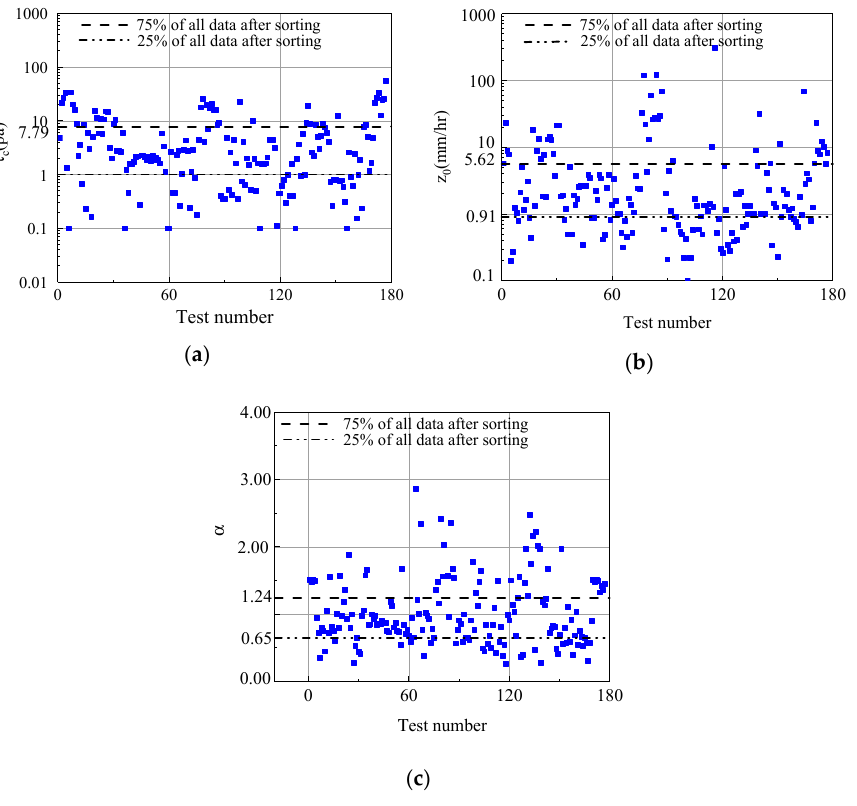
Figure 2. Erodibility parameters of the excess stress shear model: the critical shear stress ( τ c ) ( a ); the erodibility parameters Z 0 ( b ); an empirical exponent α ( c ).